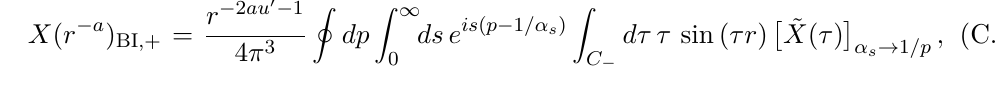
figure 10. This contour is obtained by a continuous deformation of the closed contour surrounding the origin p = 0 in a small | p |